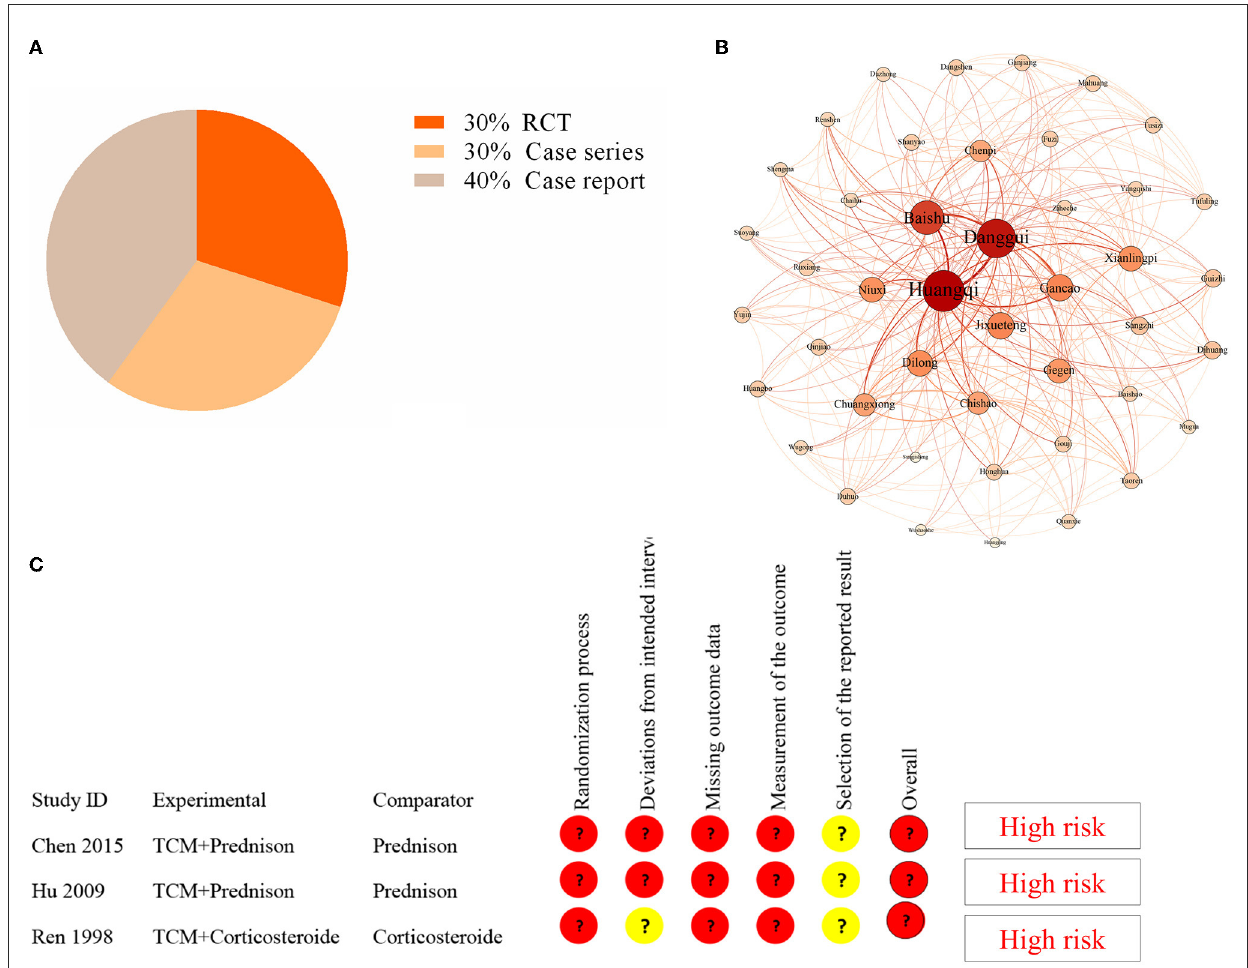
FIGURE3 Analysis in the literature review. (A) The distribution of study design in the included studies. (B) Complex network analysis of selected TCM formulas from the included studies. (C) The results of the quality assessment of three RCT studies by using the risk bias assessment tool